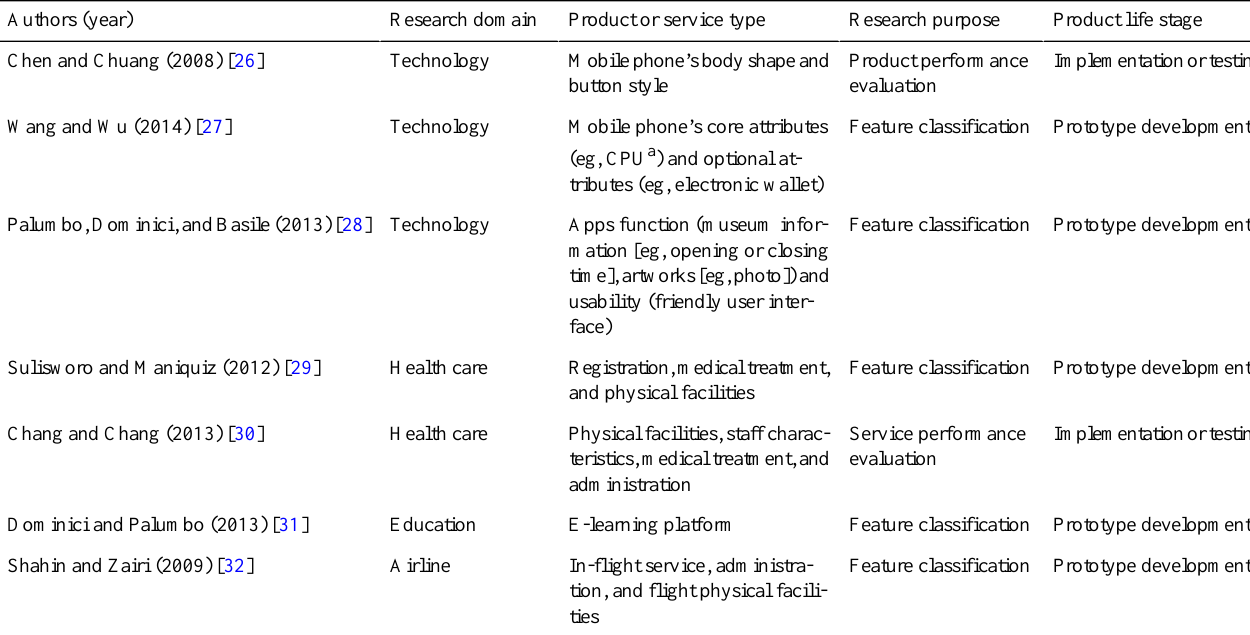
Table 1. Empirical studies with the Kano